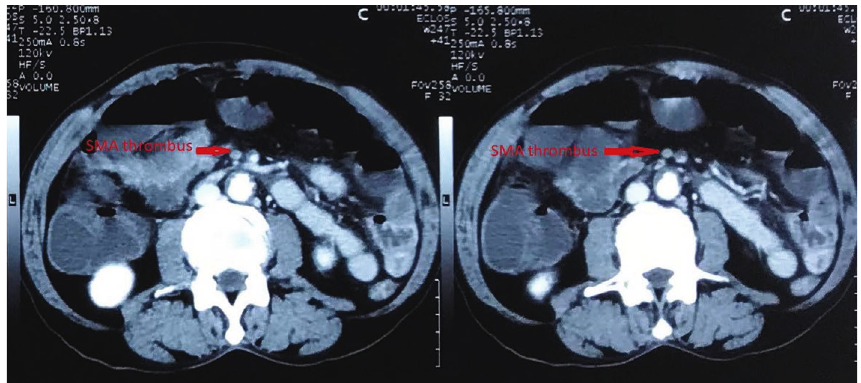
Figure 1: CT scan depicting SMA thrombosis.